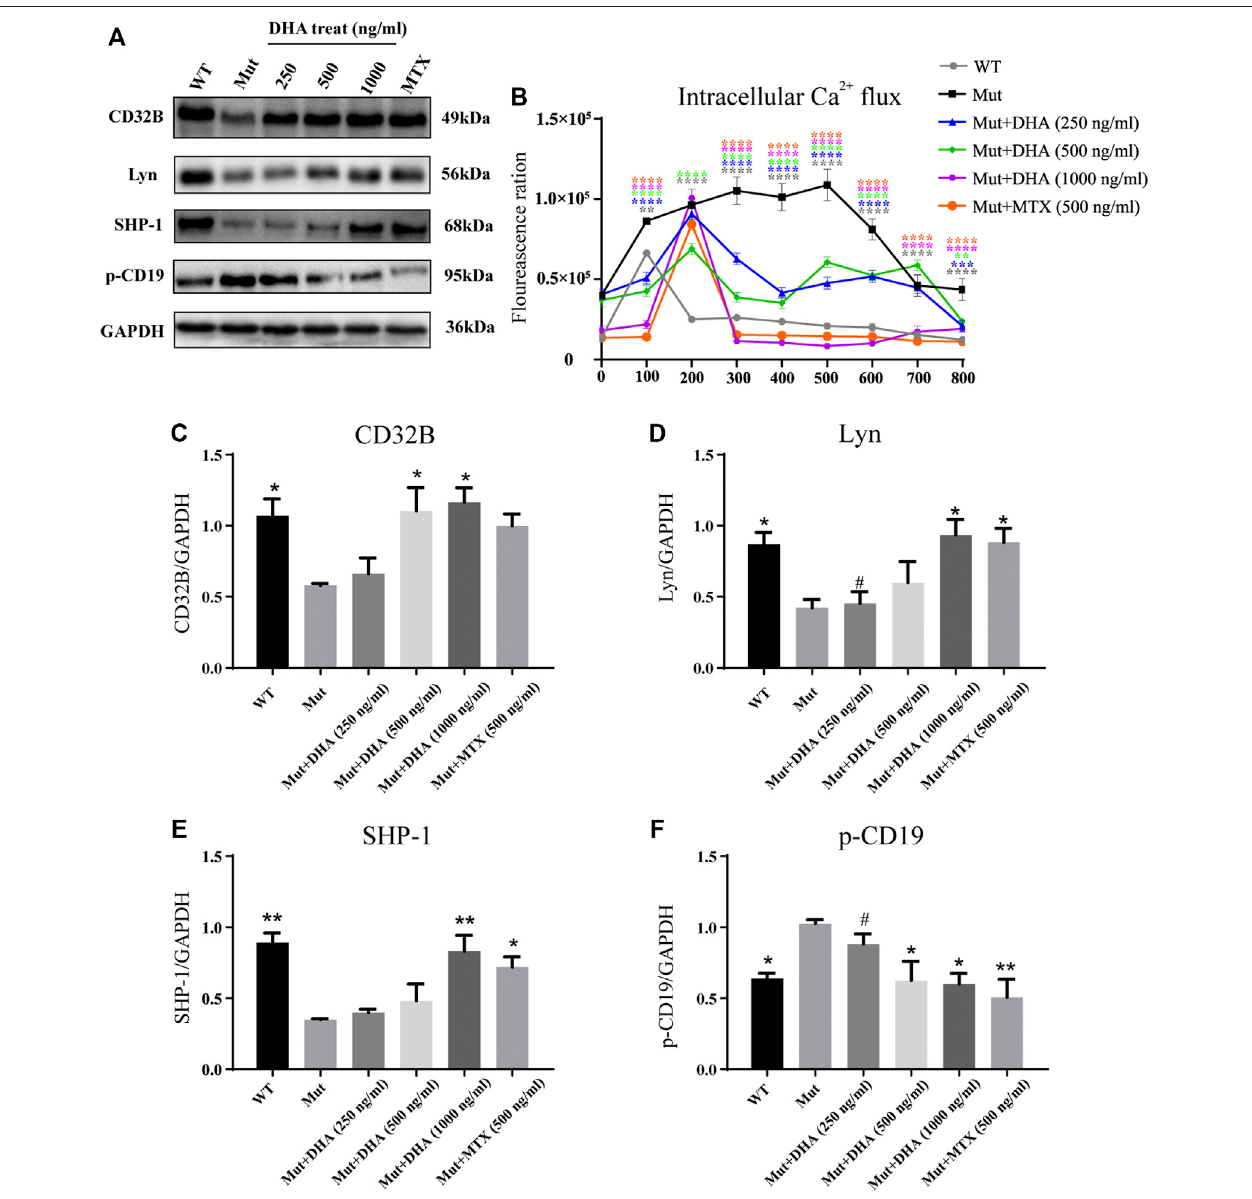
FIGURE 5 | Regulation of DHA on CD19/Fc γ RIIb-Lyn-SHP-1 pathway and effect of intracellular Ca 2+ fl ux in ST486 cells. (A) The cells were treated as above, and then stimulated with anti-human IgM (20 μ g/ml) for 1 h. The protein expression levels of CD32b (Fc γ RIIb), GAPDH, Lyn, phospho-CD19 and SHP-1 were detected by western blot. This part of the experiment was repeated three times. (B) The cells were incubated in RPMI 1640 medium containing 10% fetal bovine serum and Fluo-4 AM (5 μ mol), incubated at 37 ° Cfor 1 h, washed 3 times,and continuously monitored by fl owcytometry.Anti-humanIgM (20 μ g/ml) wasadded at 50 s, add CaCl 2 to the fi nal concentration of 2 mM at 400 s, and the intracellular Ca 2+ fl ux was continuously detected to 800 s (C – F) With GAPDH as the internal reference, the relative expression ofeach proteinwasexpressedastheprotein/GAPDH.Theexperimentswererepeatedthreetimesandanalyzedusingone-wayANOVA.* p < 0.05and** p < 0.01 vs. the Mut group; # p < 0.05 vs. the MTX